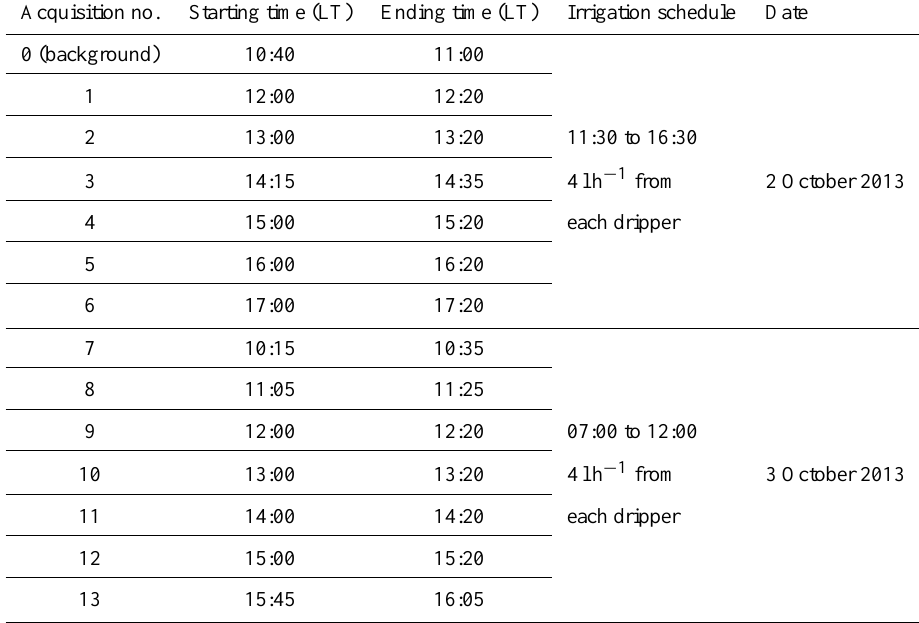
Table 1. Times of acquisitions and irrigation schedule Acquisition